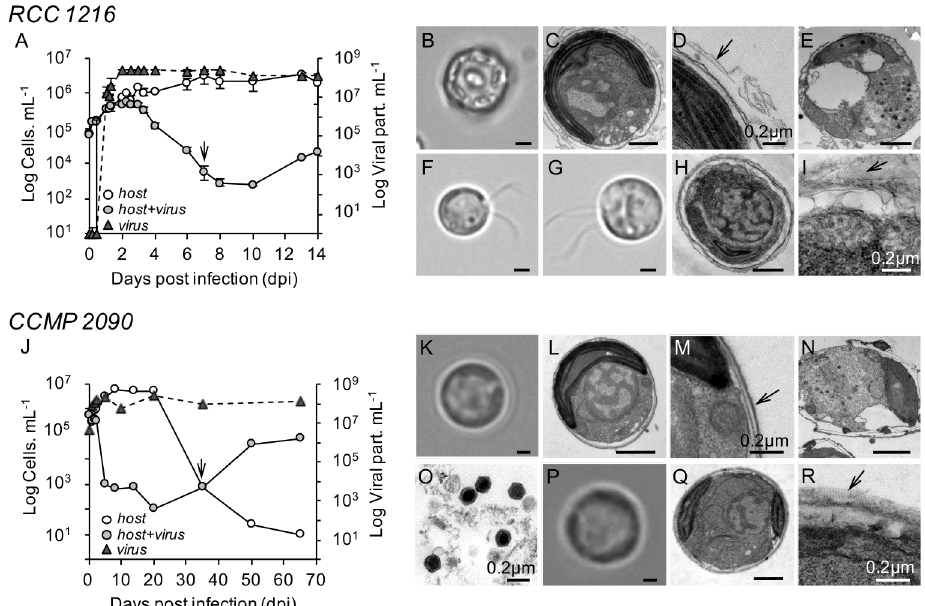
Fig 1. Host–virus dynamics and ultrastructural featuresof E . huxleyi cells. (A–I) Dynamic of growth infectionand ultrastructural features of E . huxleyi RCC 1216, a 2N calcifiedstrain. (A) Temporal dynamics of E . huxleyi duringinfectionby EhV-201comparedto uninfected, control conditions. The arrow denotes the time (7 dpi) at which virus-resistant, biflagellatecells are first detected by light microscopy. (B–D) Light microscopy (LM) and transmission electron microscope (TEM) imageryof RCC 1216 cells. The close-up (D) highlightsthe presenceof remnants of the organic matrix of coccoliths as indicateby an asterisk, but not organic scales. (E) TEM micrographof an EhV-infectedcell with multiplevirions detected as dark electron- denseparticles in the cytoplasm. (F) LM image of a haploidcell (RCC 1217), shown for comparison (see text for details). (G–I) LM and TEM images of a biflagellate cell isolated postinfection. The close-up(I) denotes the presenceof organic scales (arrow) with patterns of fibrils bound to the cell membrane. (J–R) Dynamic of growth infectionand ultrastructural features of E . huxleyi CCMP 2090, a 2N noncalcified strain. (J) Temporal dynamics of E . huxleyi duringinfection by EhV-201 as comparedto uninfected, control conditions. The arrow denotesthe time (35 dpi) at which virus-resistant nonmotilescale-bearing cells (nonmotile-S cell) were first detected by LM. (K–M) LM and TEM images of CCMP 2090 cells. (M) Arrow denotesthe absenceof organic scales bound to the cell membrane. (N) Cell infected by EhV, as describedabovein (E). (O) Close-upof EhV virions upon cell lysis. (P–R) LM and TEM images of nonmotile-Scells postinfection. The close-up(R) denotesthe presenceof organic body scales (arrow), as describedin (I). The mean ± standarddeviationof duplicatecultures is shown. The scale bars are 1 μ m for all TEM images, except for images D, I, M, O and R in which the scale bar = 0.2 μ